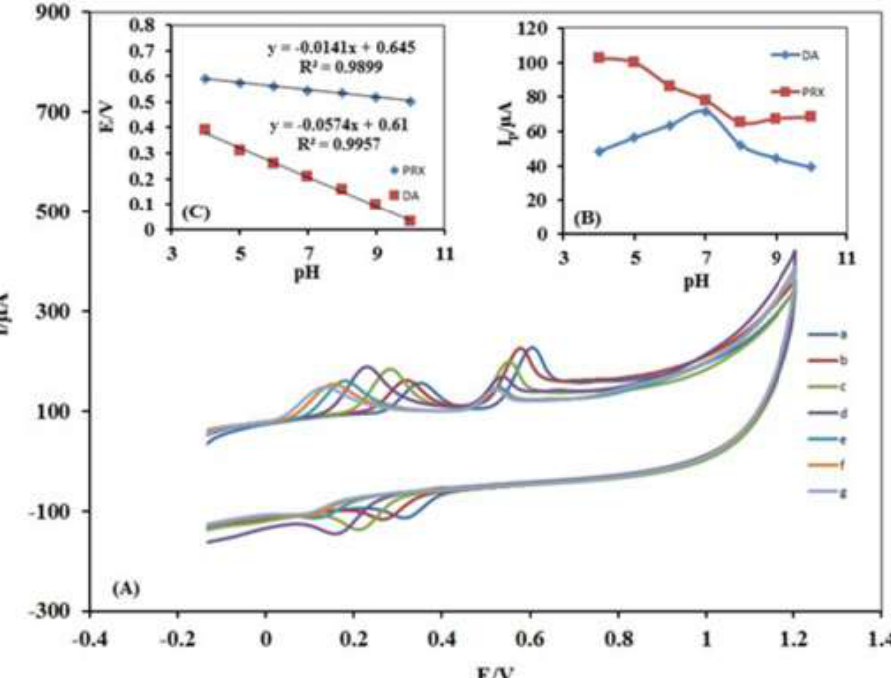
Fig. 3. (A) Cyclic voltammograms of 80 μM DA and 100 μM PRX compounds at PGA/TOHS/MWCNTs/CPE in 0.1 M ammonia buffer solution at different pHs: 4(a), 5(b), 6(c), 7(d), 8(e), 9(f), 10(g). Insets: (B) Plot of anodic peak currents (Ipa) of DA and PRX as a function of pH values. (C) Plot of potential values as a function of pH